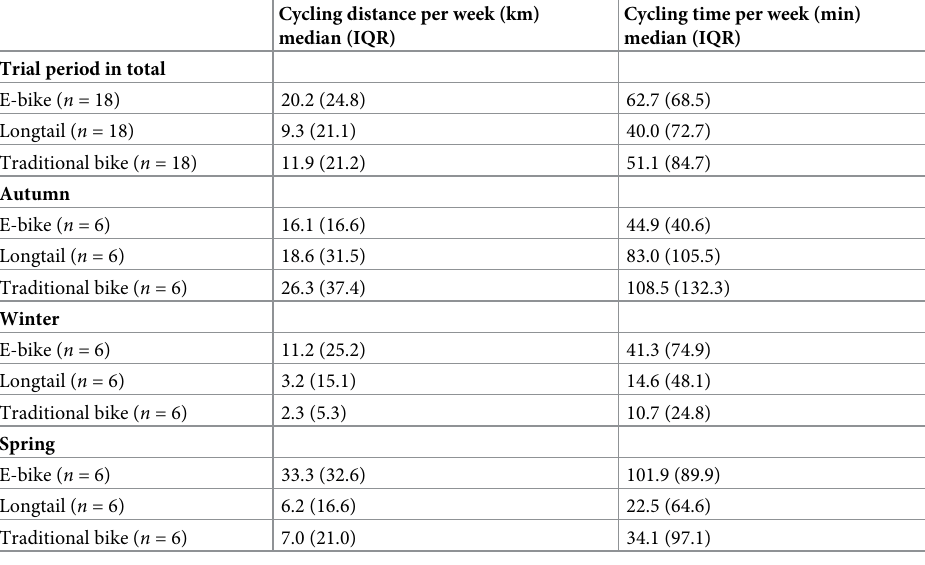
Table 3. Cycling distance and time per week for the total trial and for each season across bike